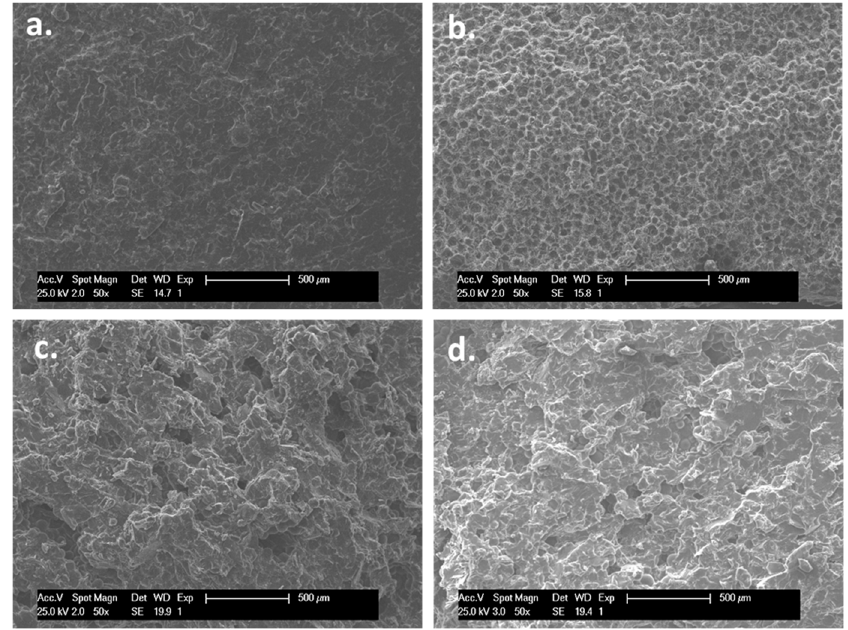
Figure 3. The SEM images (50×) of ( a ) control ABC, ( b ) ABC with 0.3% GO, ( c ) ABC with 15% CS, and ( d ) ABC with 0.3% GO and 15% CS samples.